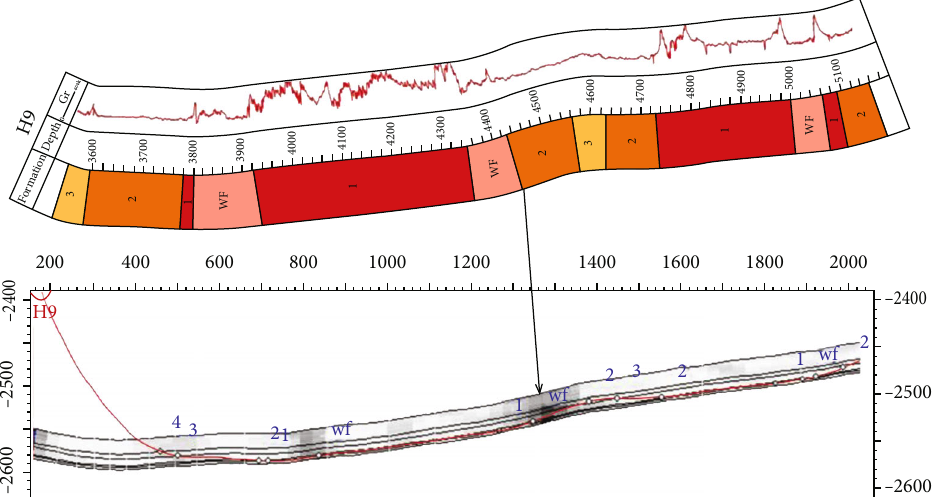
Figure 6: Pro fi le of ant tracking in well H9.